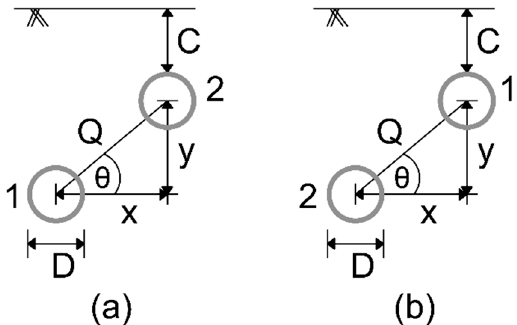
Figure 1. Offset arrangement twin tunnels. ( a ) Lower tunnel is excavated first, and ( b ) upper tunnel is excavated first.